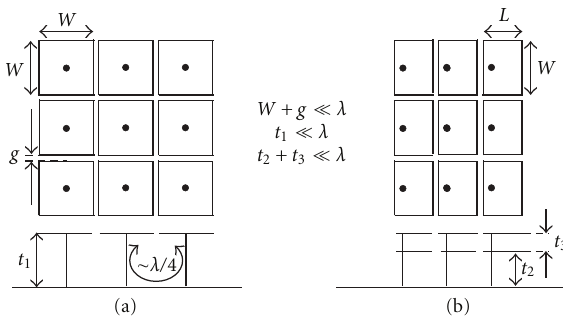
Figure 2: Layer and top views of traditional EBG structures (a) and multilayered F structure (b).